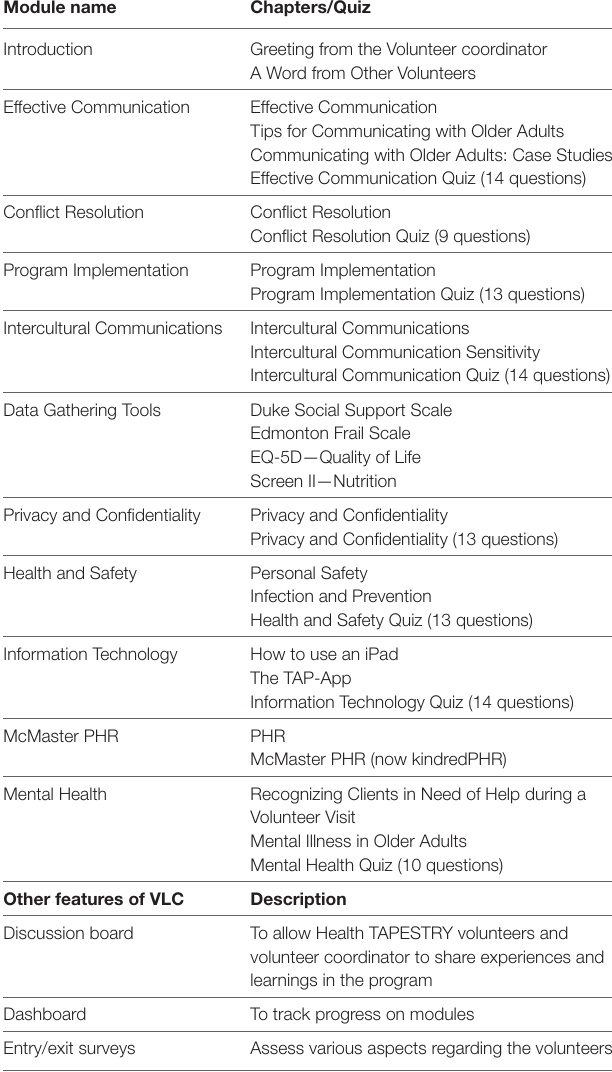
table 3 | Modules and other features on the Virtual Learning Centre